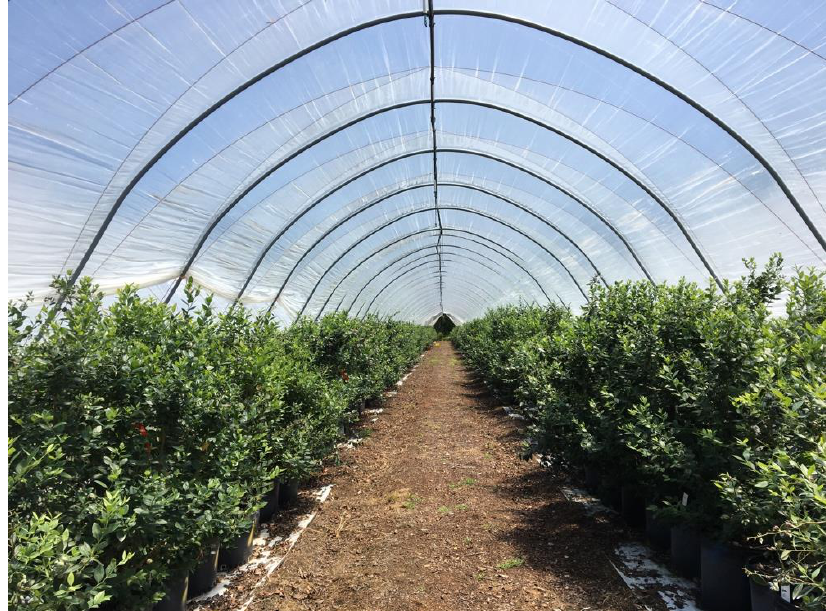
Figure 1. Southern highbush blueberry planted in a combination of alternative production systems including high tunnel, high density (10976 plants per hectare), evergreen, and containerized soilless substrate production systems in north Florida.